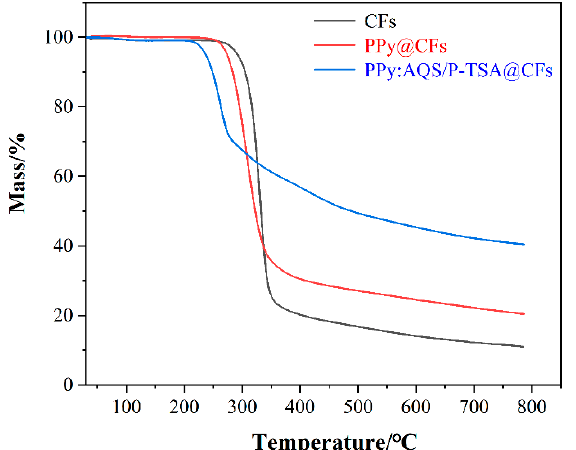
Figure 4. Thermogravimetric curves of CFs, PPy@CFs, and PPy@AQS/p-TSA@CFs.